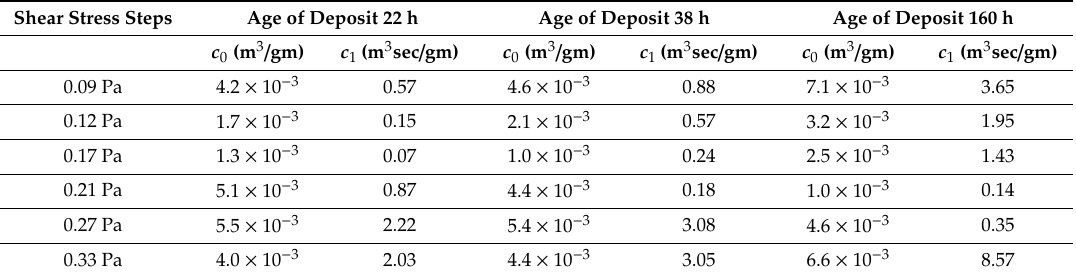
Table 1. Fitting coe ffi cients c 0 and c 1